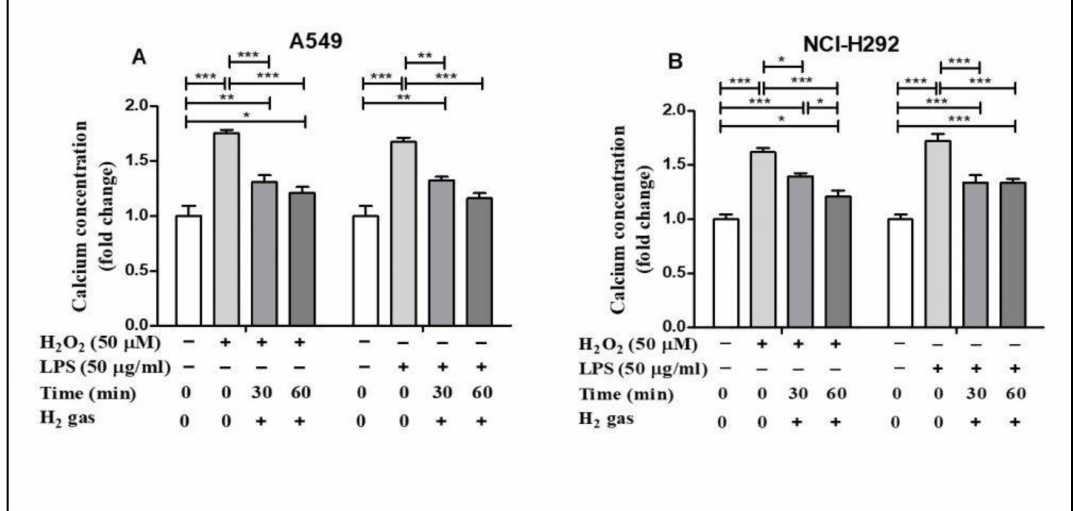
Figure 5. Effect of 2% H 2 gas on intracellular Ca 2+ levels in H 2 O 2 and LPS-induced A549 and NCI-H292 cells. Cells were treated with 50 µ M of H 2 O 2 or 50 µ g/mL of LPS and incubated for 24 h. The cells were then washed and the media replaced with normal RPMI. The supernatant was collected after 24 h of H 2 treatment and a Ca 2+ assay was performed. Ca 2+ concentrations were measured in ( A ) A549 cells and ( B ) NCI-H292 cells using one way ANOVA. * p < 0.05, ** p < 0.01, and *** p < 0.001 represent the significance levels of the